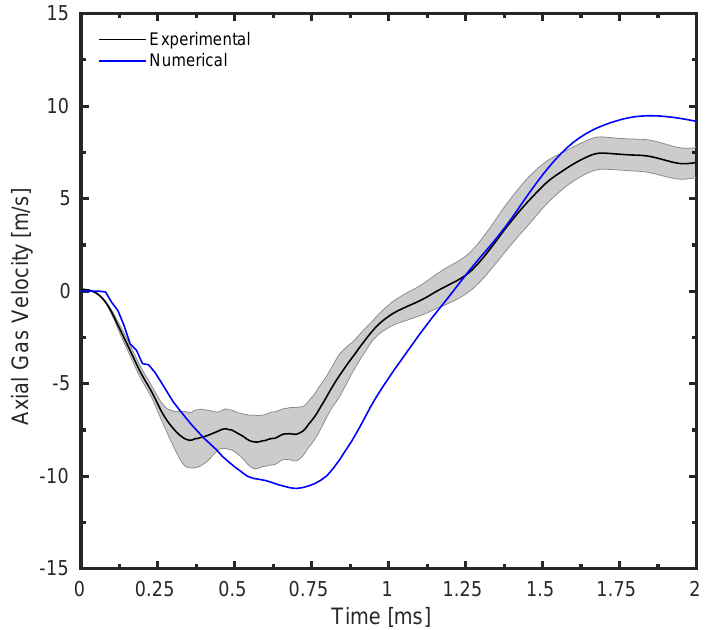
Figure 7. Numerical axial gas velocity comparison with PIV experimental data from Sandia for the baseline condition